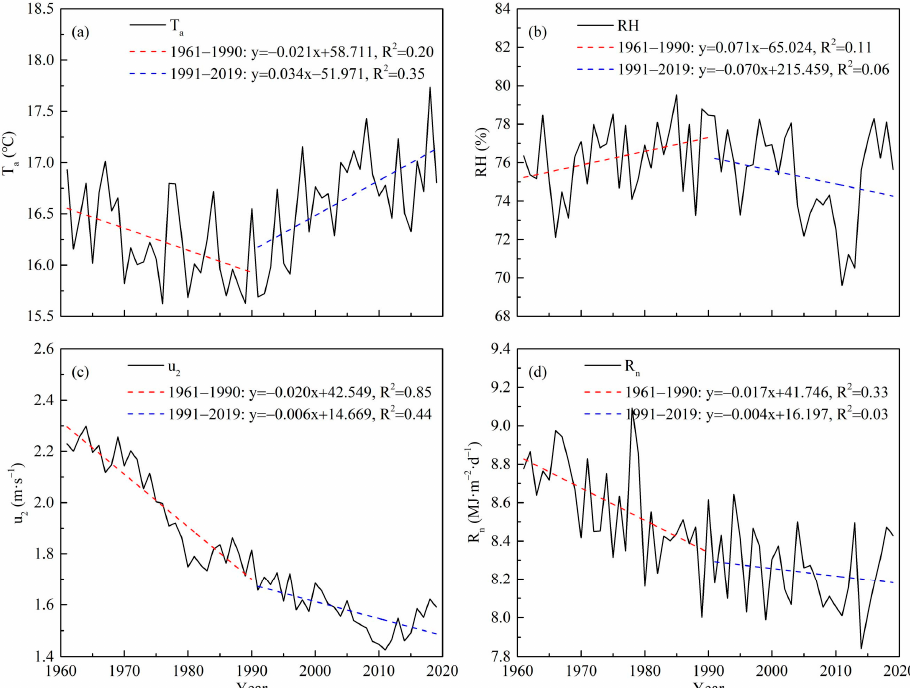
Figure 4. Temporal variations of meteorological factors ( a ) T a , ( b ) RH, ( c ) u 2 , ( d ) R n during 1961–2019 in Anhui province.